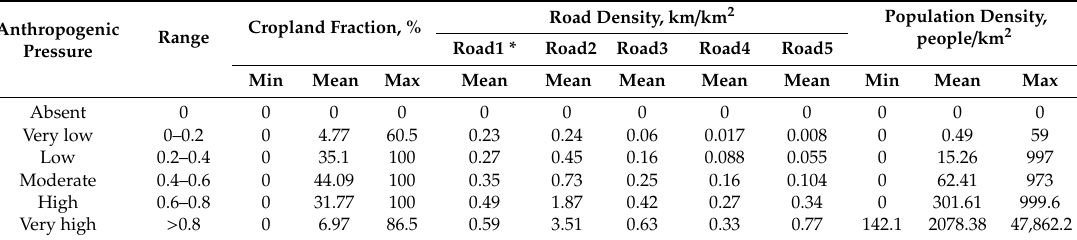
Table 7. Categories of anthropogenic